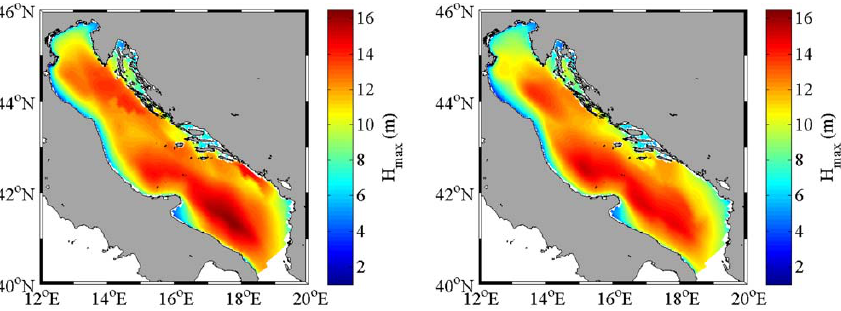
Fig. 14. Borgman’s analysis: Largest expected maximum wave height H max in a storm (in meters). Numerical simulations of the present climate (left) and the future scenario (right) are shown.